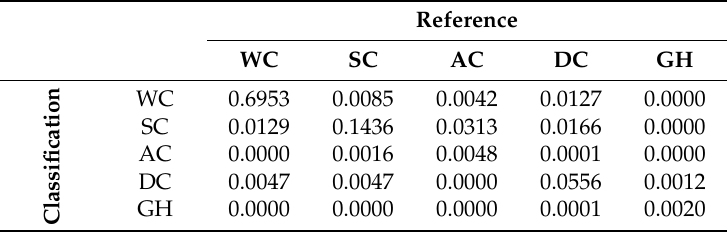
Table A4. Confusion matrix for variable subset “WKL_TC_ST”. Cells populated with adjusted probabilities [54]. WC: winter cropping, SC: summer cropping, AC: semi-aquatic cropping, DC: double-cropping, GH: greenhouse